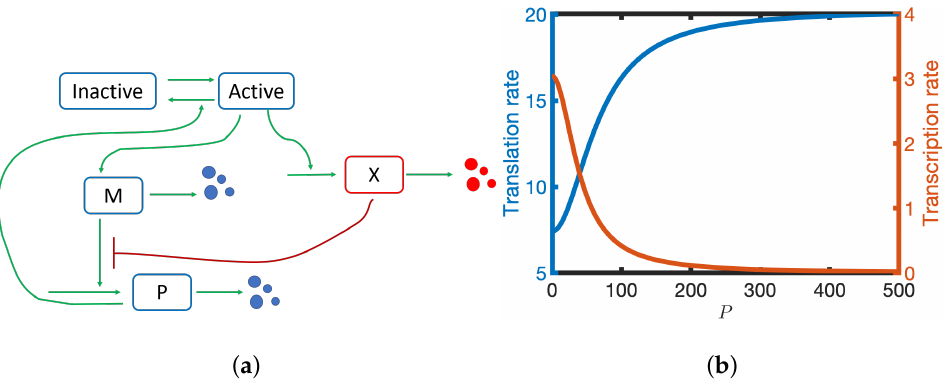
Figure 1. ( a ) A schematic diagram of the model. M—mRNA, P—protein, X—translational inhibitor. ( b ) The translation (blue line) and transcription (red line) rates are plotted against P . See Table 1 for parameter values.